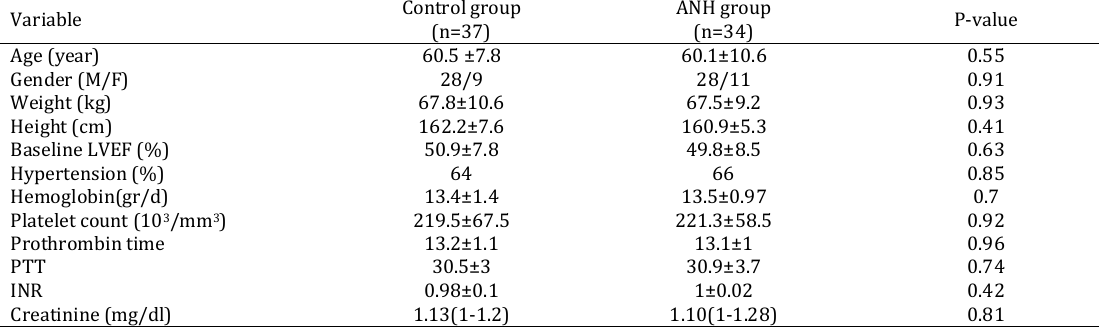
Table 1. Demographic data and baseline preoperative variables of the study groups Variable